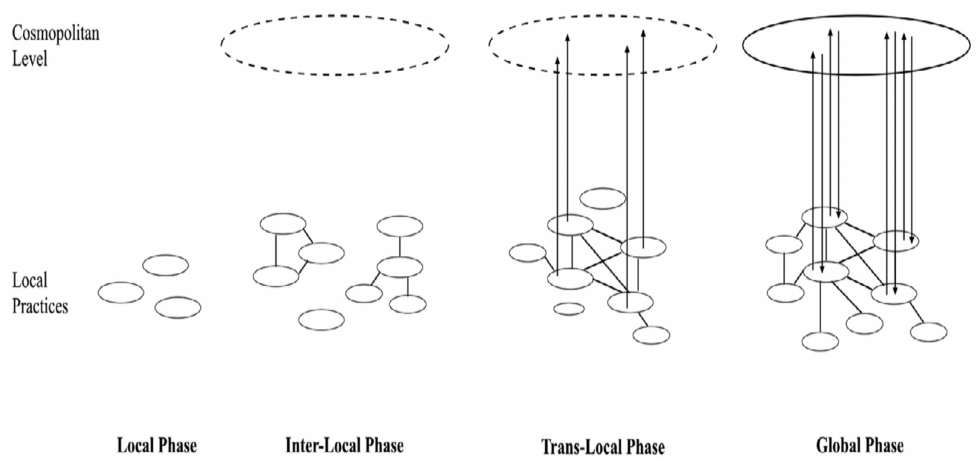
Figure 1. Phase in the development of shared technological knowledge. Source: Based in Geels and Deuten (2006: